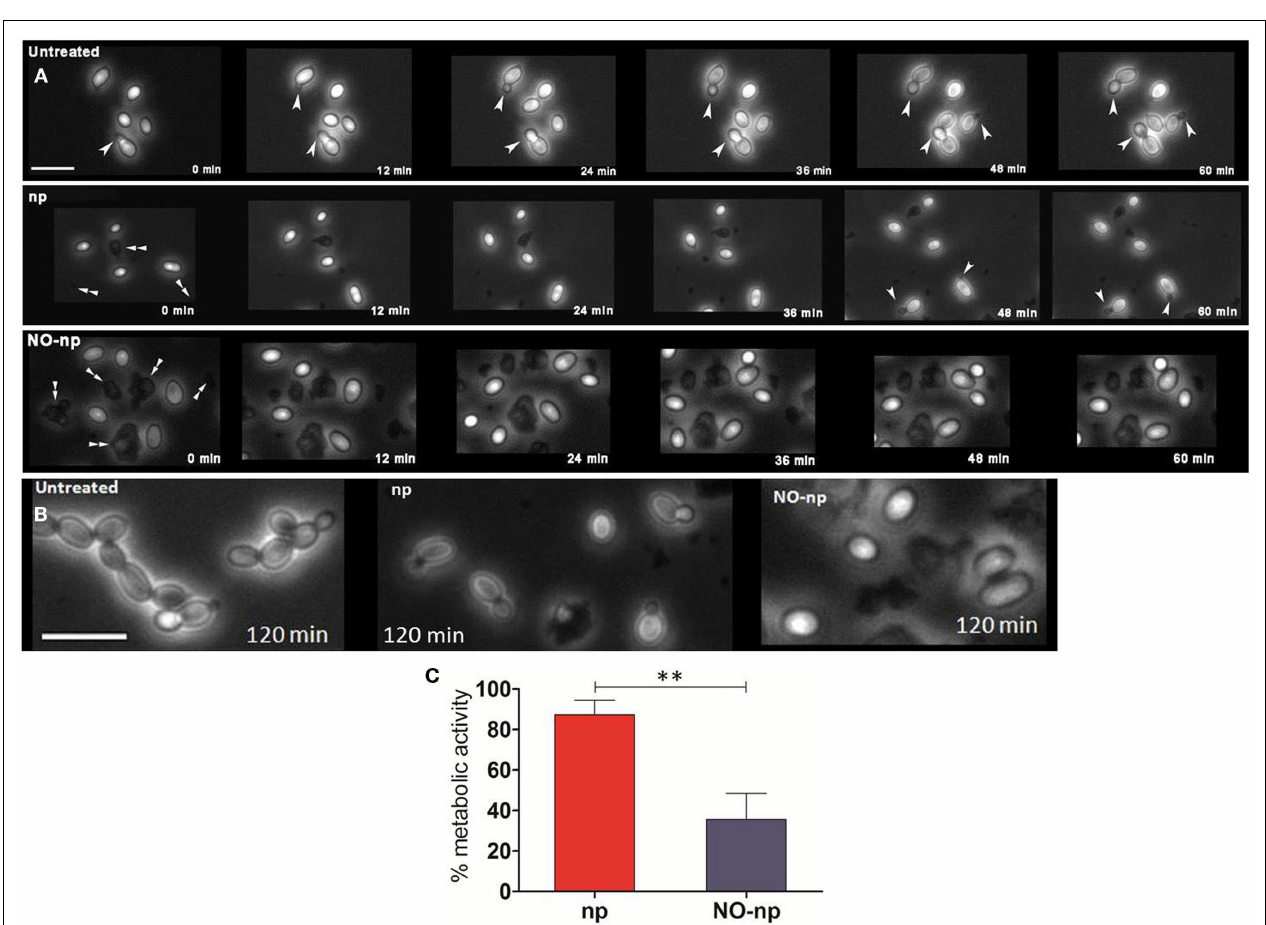
reduction assay was used to measure the metabolic activity of NO-np-treated filamentous C. albicans in vitro .The 100% activity was set as the measurements in wells with filamentous fungi without the addition of either NO-np or np. Bars represent the average of the results and error bars denote standard deviations. Asterisks denote P value significance (** P < 0.001) calculated by analysis of variance and adjusted by use of the Bonferroni correction.These experiments were performed twice with similar